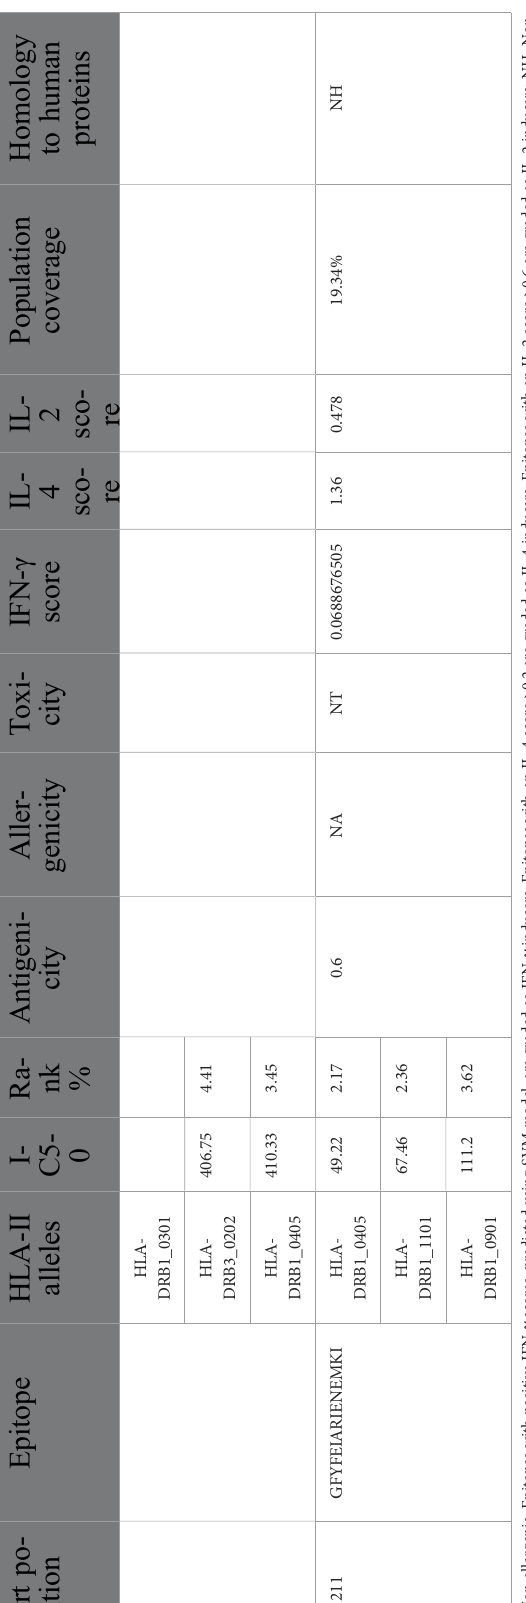
HLA-DRB1*02:01 complexes, respectively (Figure